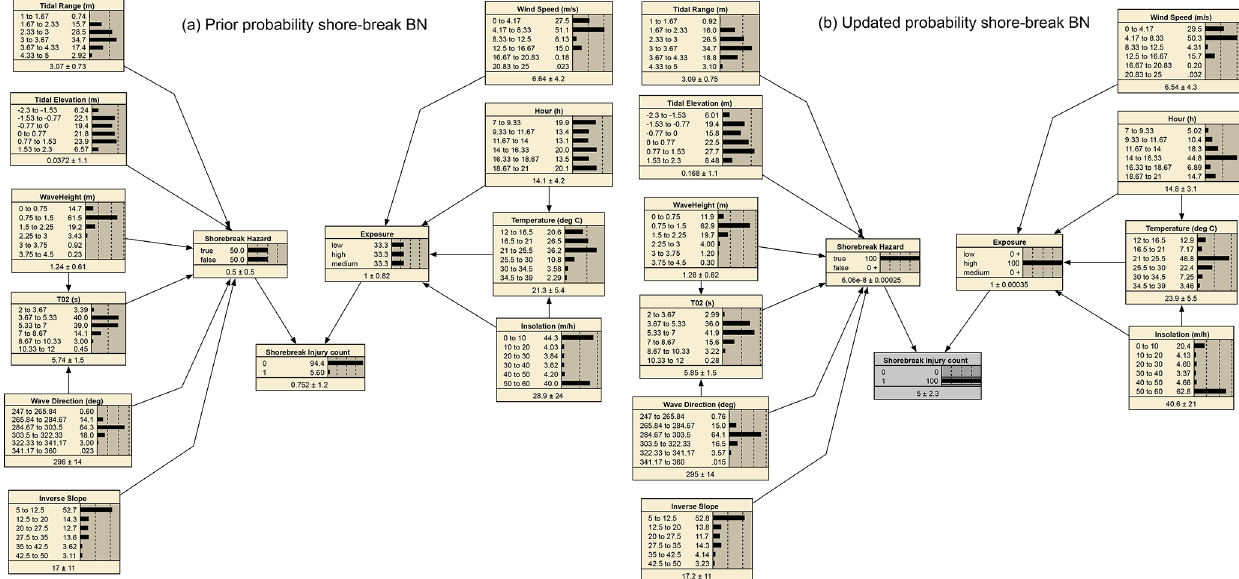
Figure 10. (a) Prior probability distribution of the shore-break BN. (b) Updated probability distribution where the probability of an injury occurring was set to 100%.